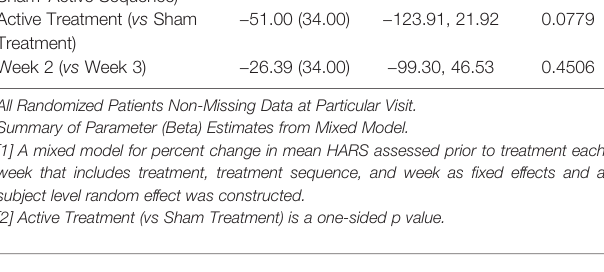
TABLE 7B | Summary of Mixed Model for Percent Change in Mean